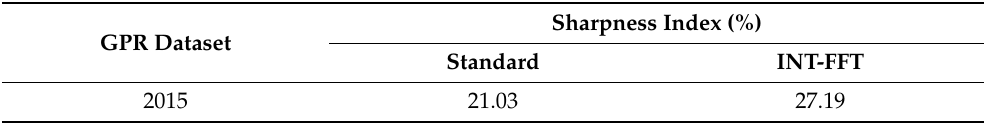
Table 6. Sharpness index of the cover surfaces from 2015 GPR datasets before and after INT-FFT processing. The sharpness increases with additional applied